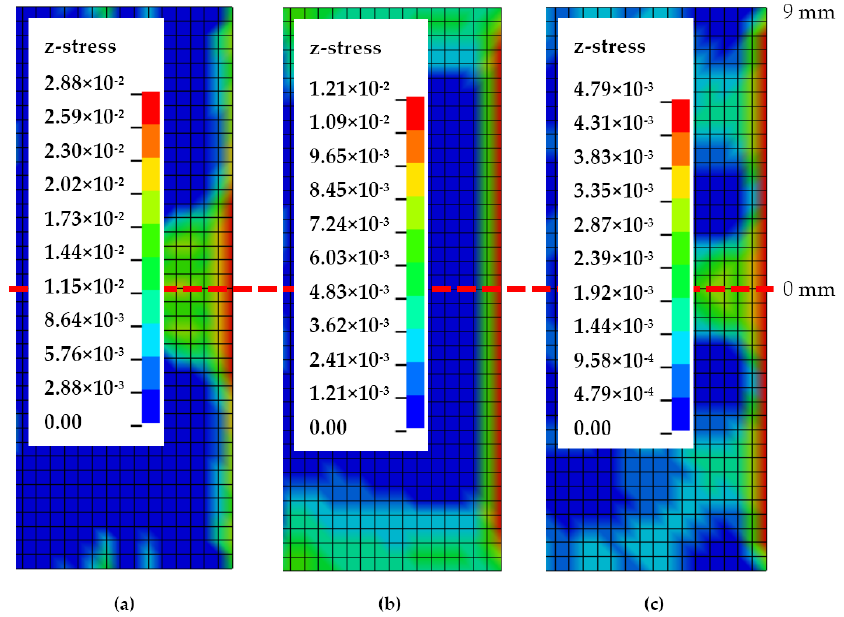
Figure 7. Mode-I crack front stress distribution at ( a ) 30, ( b ) 70 and ( c ) 110 °C.